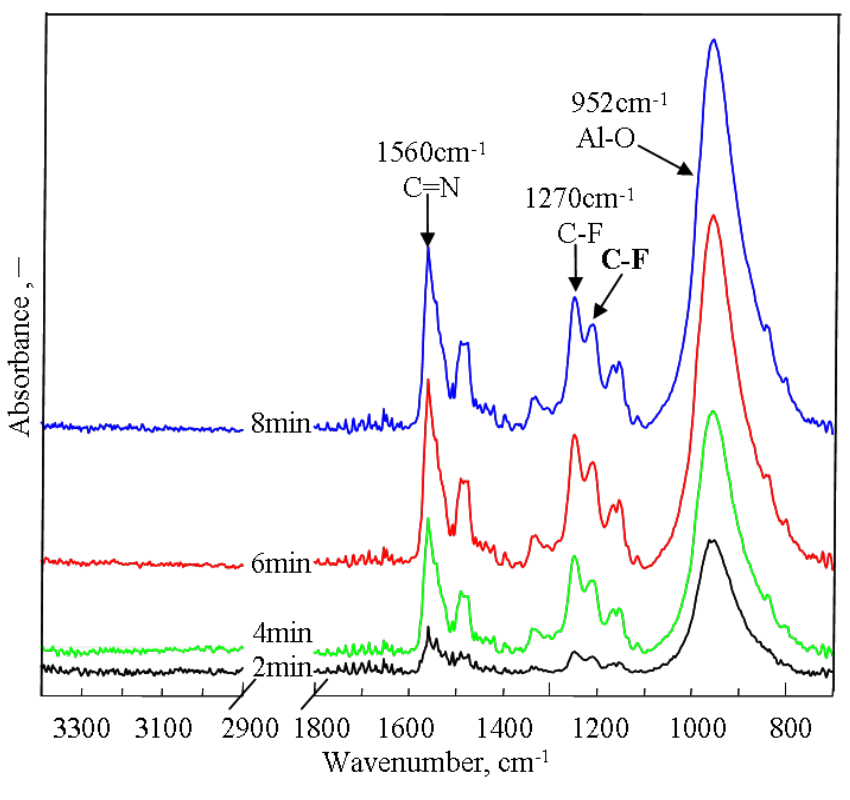
Figure 3. FT-IR spectra of PAF17 nanofilm obtained using different electropolymerization times. Electropolymerization conditions (Current density: 0.3 mA/cm 2 ; Concentration of AF17N: 5 mM; Electropolymerization temperature: 25 °C; Electropolymerization time: 2, 4, 6, 8 min).